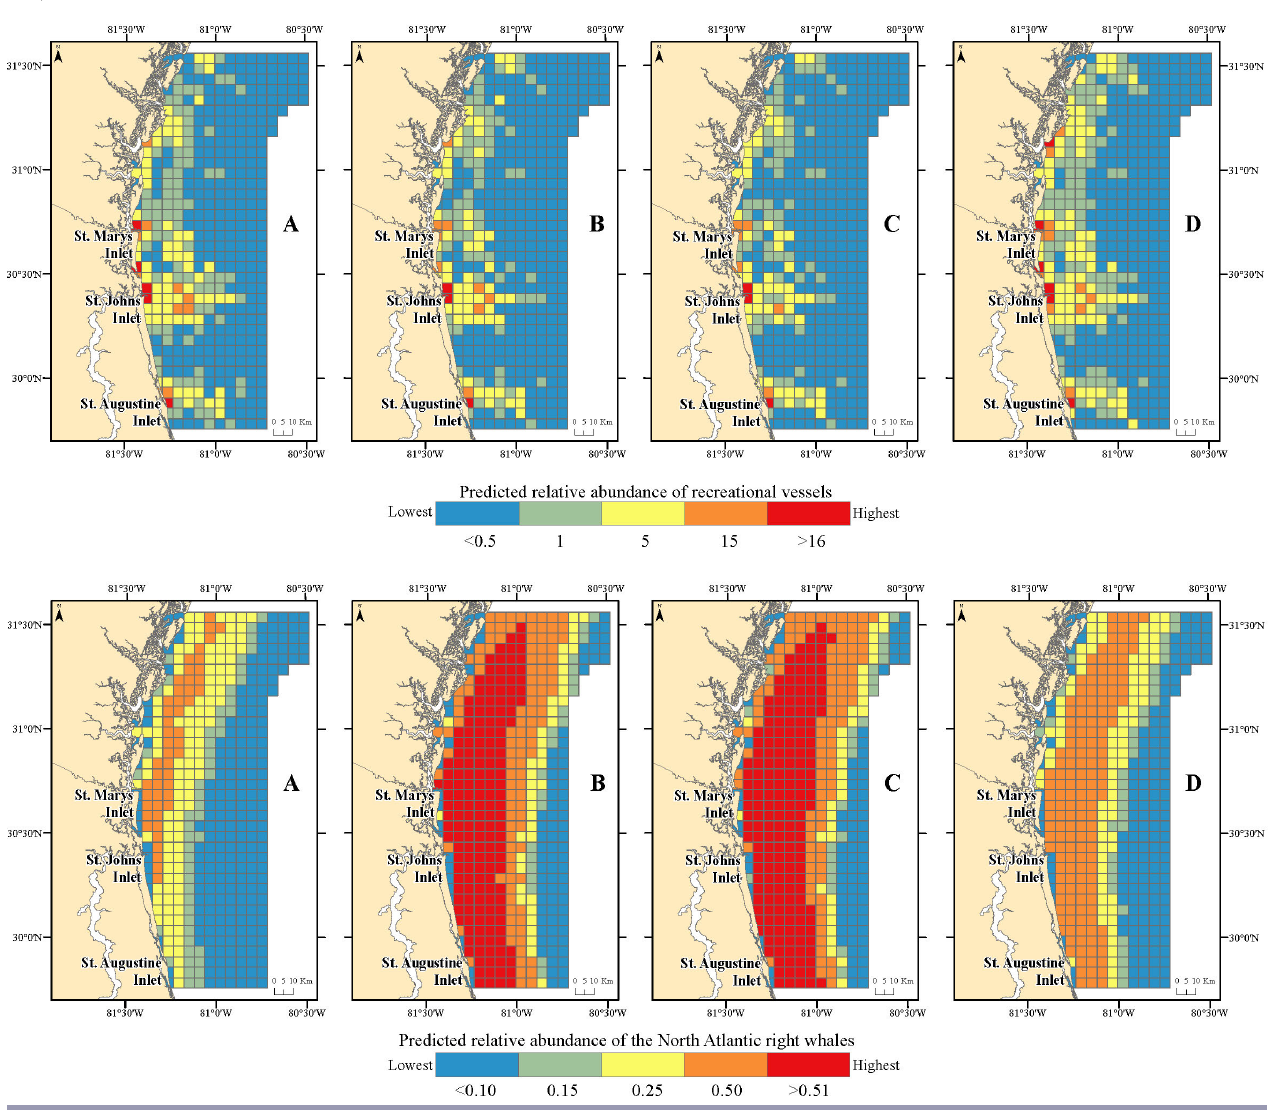
Fig. 3. Choropleth maps showing the geometrical interval distribution of monthly recreational vessel abundance predicted by the best-fit GAM (top panel) and North Atlantic right whale relative abundance based on model produced by Gowan and Ortega-Ortiz (2014; lower panel). December (A), January (B), February (C), and March (D). Sampling grid cells are 5.56 x 5.56 km cells ( n =